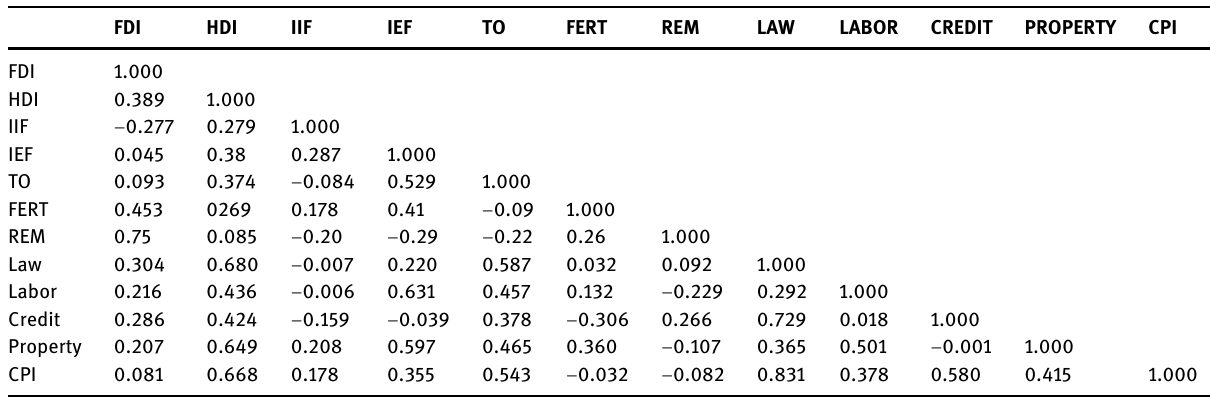
Table A3: Correlation matrix for Western Balkans ( 2002 – 2021 )